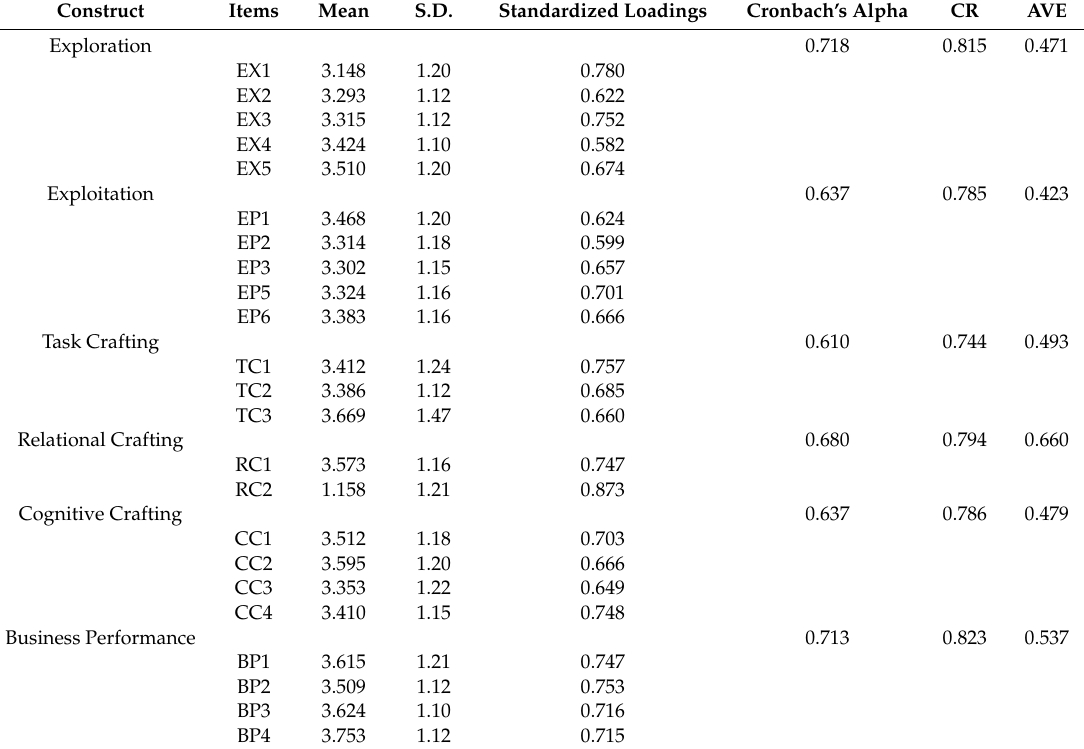
Table 1. Means, standard deviations, loading ( λ ), Cronbach’s Alpha, composite reliability, and average variance extracted (AVE).